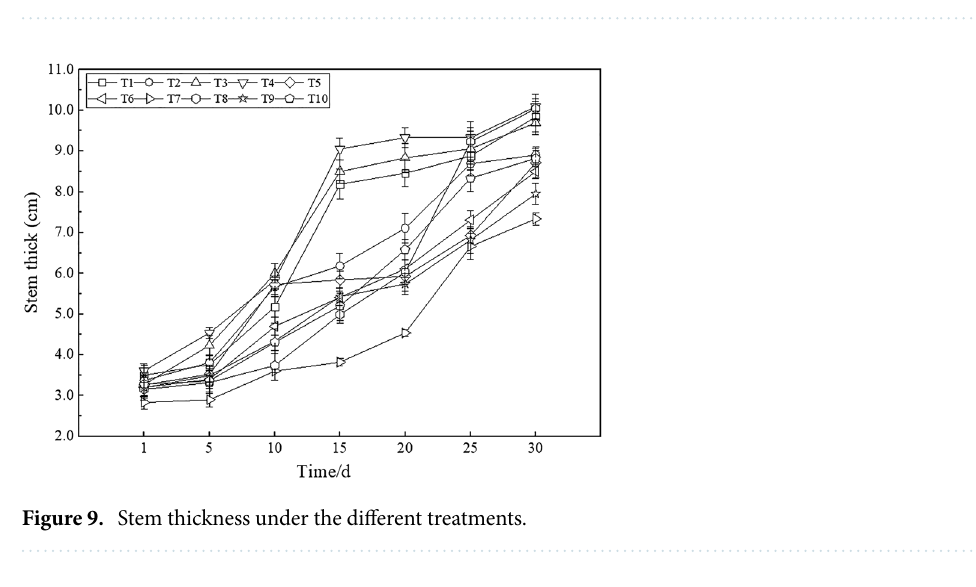
Figure 8. Plant height under the different treatments.